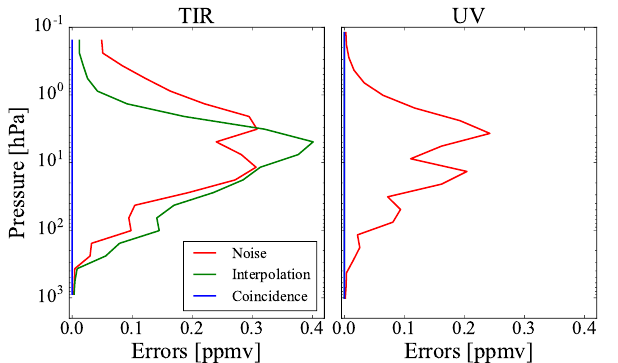
Figure 4. Noise errors (red lines), interpolation errors (green lines) and coincidence errors (blue lines) in case 2 for TIR and UV mea- surements.